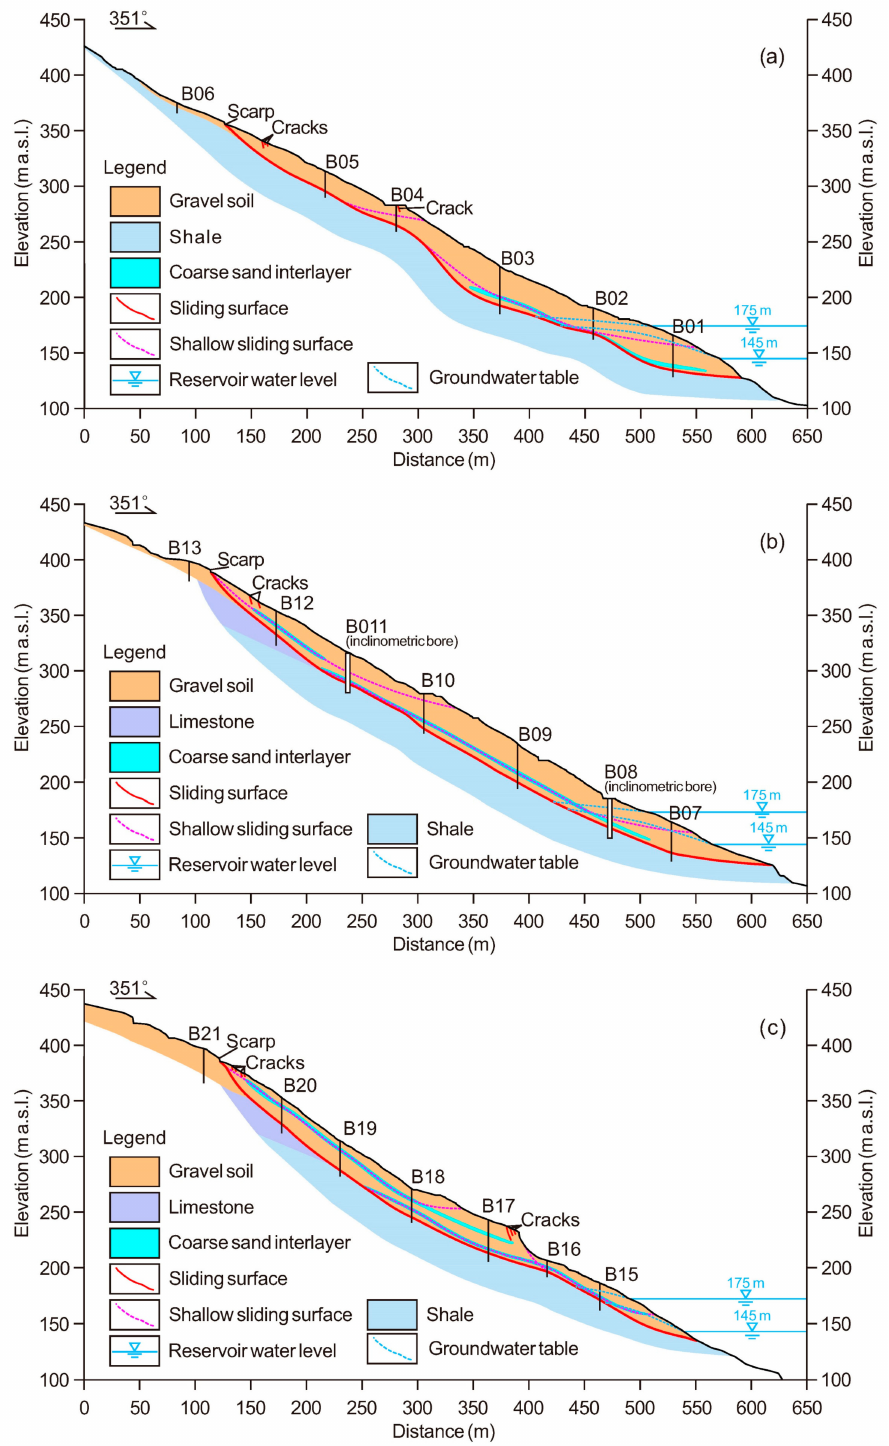
Figure 5. Geological sections of the Ganjingzi landslide: ( a – c ) longitudinal geological section B-B’, C-C’, and D-D’. Please see the location of geological sections in Figure